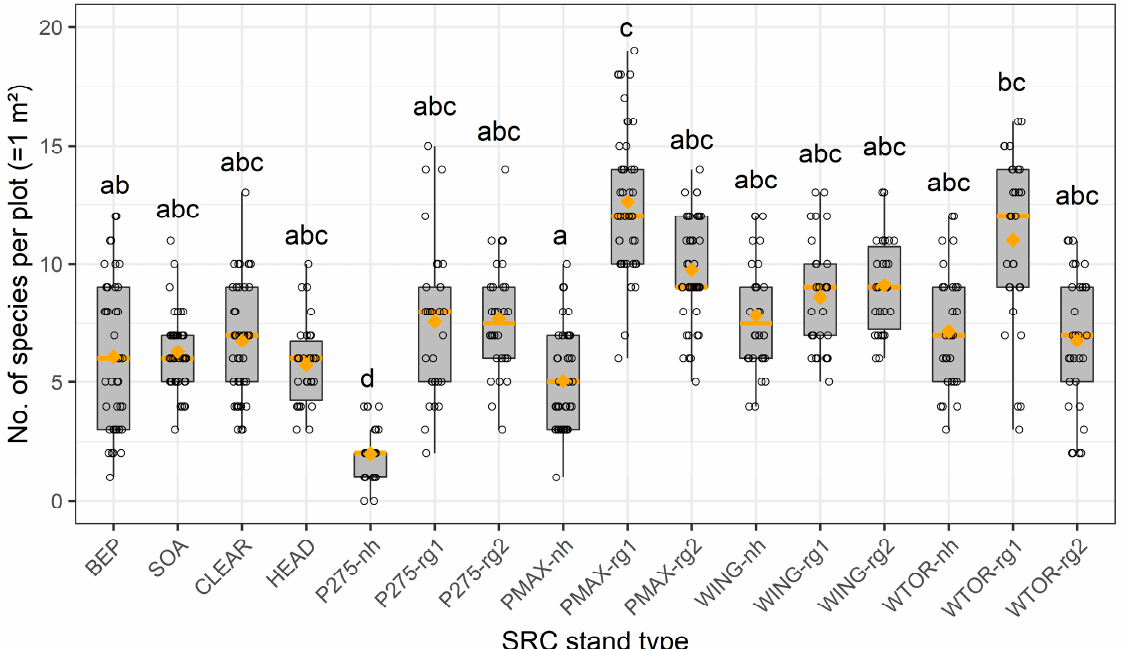
Figure 6. Species numbers of the different SRC stand types at plot-level. Types with no consistent letter indicate significant differences ( p < 0.05). Median values are presented as horizontal lines, mean values as orange diamonds. Unfilled circles show the data of the single plots sampled per type. In each boxplot, the boundaries of the box are the 25th and 75th percentiles and the whiskers represent the lowest and largest values no further than 1.5 times away from the 25th and 75th percentiles. See Table 2 for abbreviations of stand types.